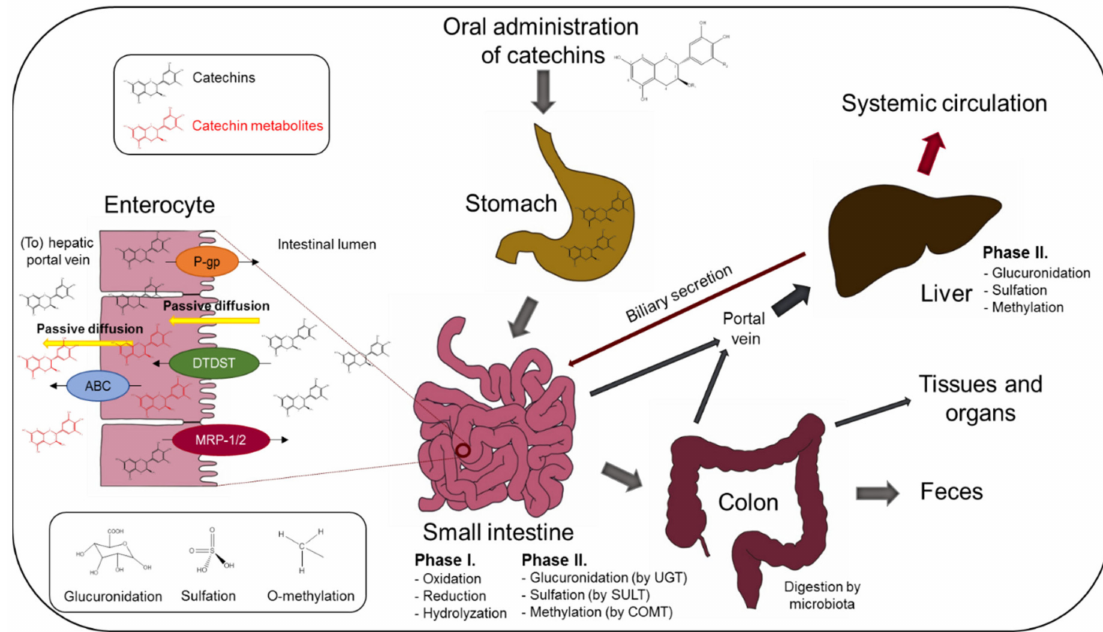
Figure 2. Metabolization of catechins in the body. After oral ingestion, catechins pass downstream via the organs of the gastrointestinal tract, including stomach, small intestine, liver (by portal vein), and colon. In the process of systemic biotransformation, catechins are metabolized by enzymes of phase I and phase II metabolism in small intestine and/or liver and by gut-microbiota in colon, causing modifications to have higher bioavailability. In the small intestine, catechins are transported from intestinal lumen to enterocytes mostly by passive diffusion and undergo phase I and II enzyme modifications. Recently, a novel transporter of EGCG, DTDST, was identified [47]. Two known transporters are responsible for lower bioavailability of catechins by transferring them from enterocyte back to intestinal lumen, P-gp and MRP-1/2. Otherwise, catechins and catechin metabolites continue from enterocytes by passive or active transport (by ABC transporters) via hepatic portal vein to liver and further to systemic circulation, or they are secreted back to the small intestine by bile. A fraction of unprocessed catechins, catechin metabolites, and catechin oligomers or polymers undergo final metabolization in the colon by gut-microbiota or are unabsorbed and excreted by feces. Degradation by microbiota leads to formation of small absorbable phenolic acids transported to tissues and organs, where they perform their biological activities. Abbreviations: P-gp, P-glycoprotein (ATP-dependent protein pump); MRP-1/2, multidrug resistance-associated protein 1 or 2; DTDST, diastrophic dysplasia sulfate transporter; ABC, ABC transporter; UGT, UDP-glucuronosyltransferase; SULT, sulfotransferase; COMT,